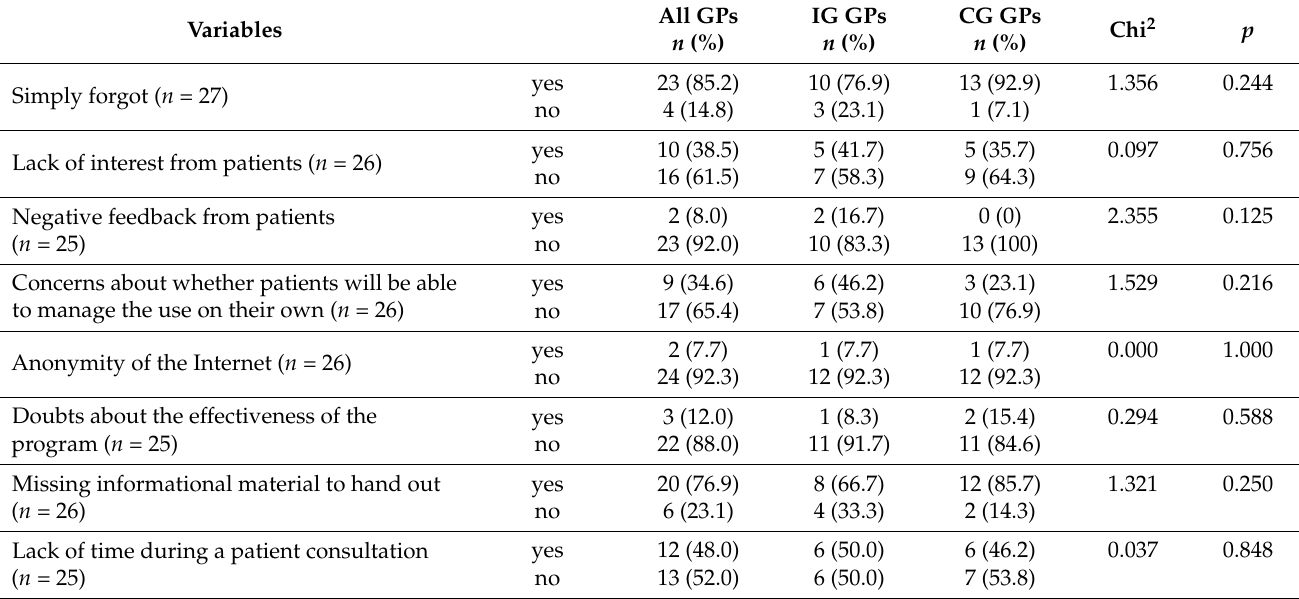
Table 3. Barriers for real-world uptake from GP’s perspectives 1